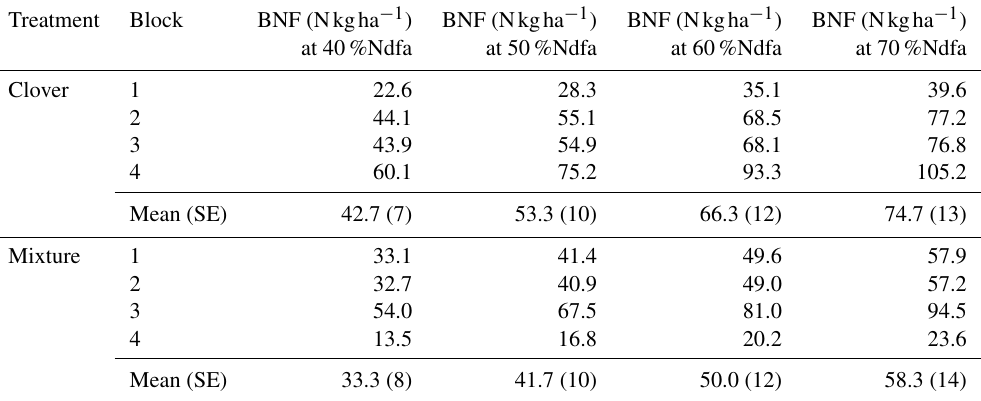
Table A3. Sensitivity analysis for the CF site where we estimated BNF at 40%Ndfa, 50%Ndfa, 60%Ndfa, and 70%Ndfa for the clover grown alone and in